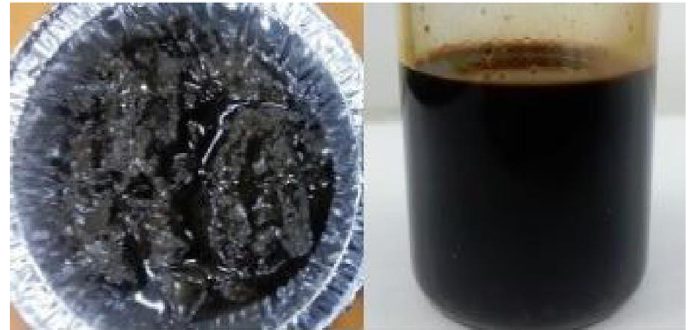
Figure 3. Oil samples and covered oil